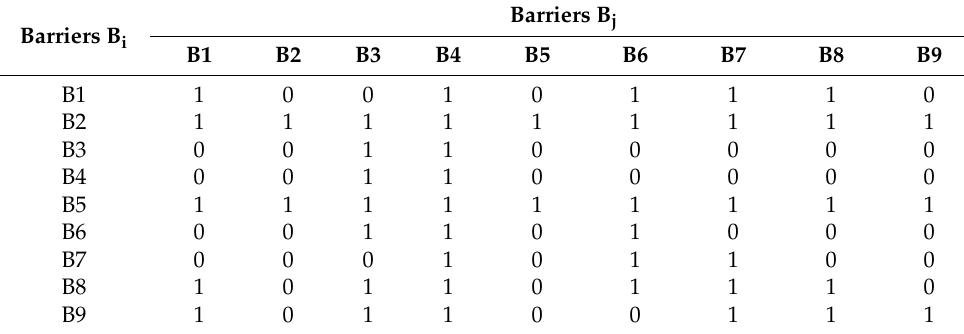
Table 6. IMR of the barriers of socio-political sustainability. Barriers B i